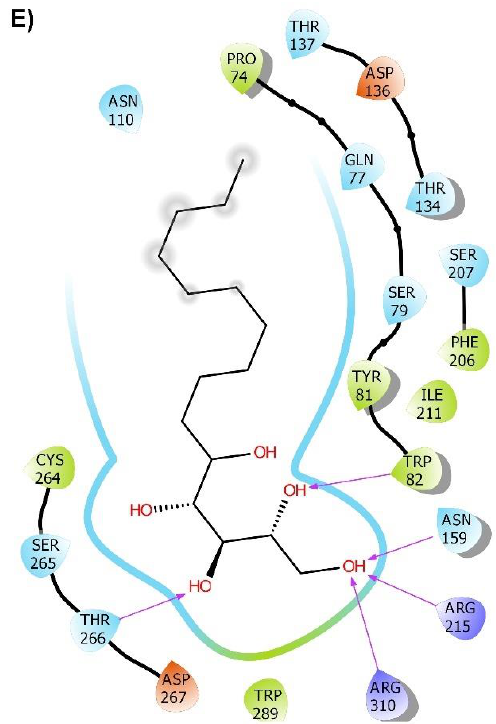
Figure 2. ( A – E ) Interaction of the top five potential hits (amino acids are depicted in different colors: green —hydrophobic, blue—polar, orange—negatively charged, purple—positively charged, pink—hydrogen bonds).